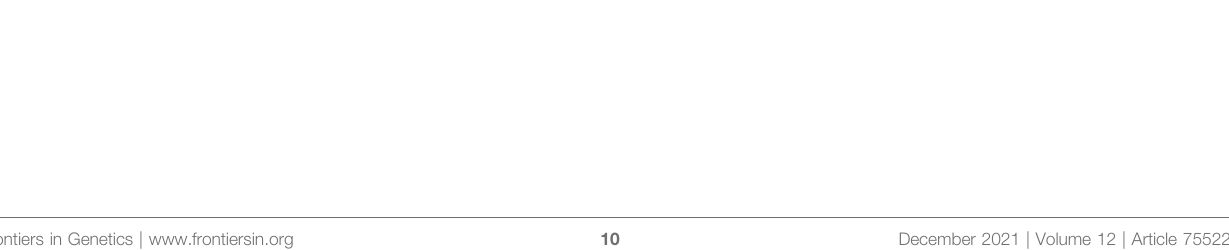
Frontiers in Genetics |